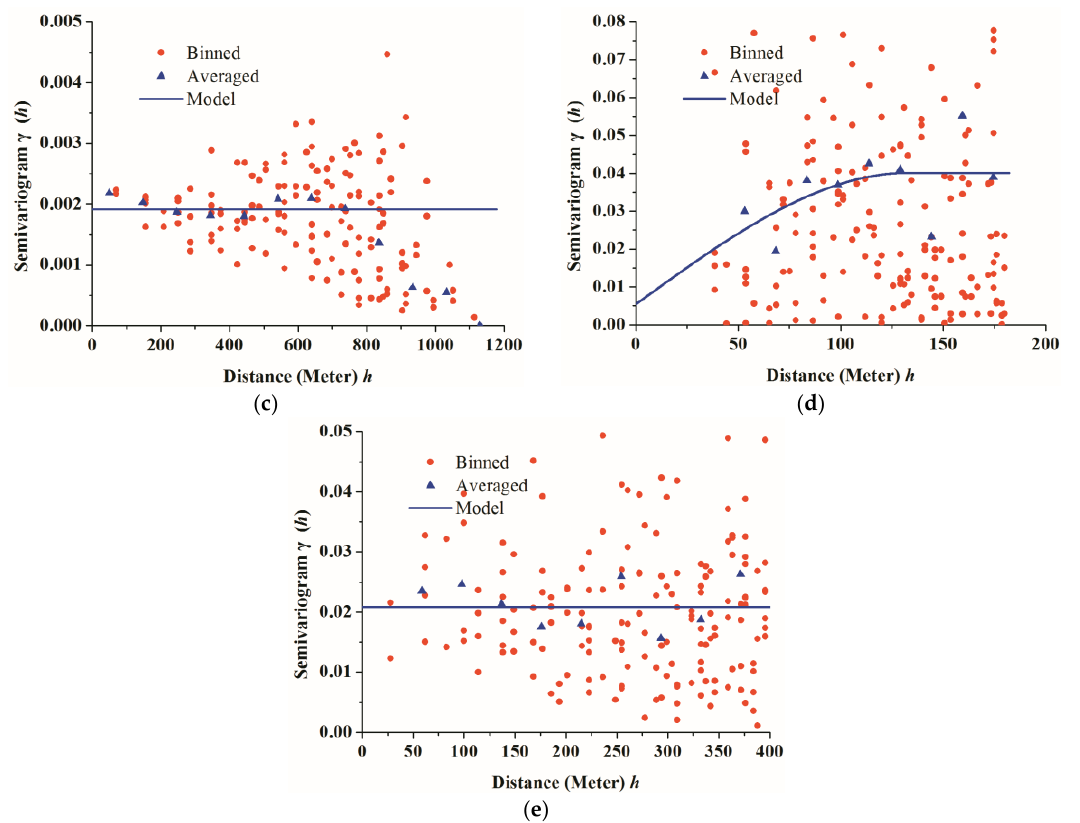
Figure 5. Semivariograms of in situ soil moisture observations: ( a ) 30 June data, using a Gaussian model; ( b ) 7 July data, using a Spherical model; ( c ) 14 July data, using a pure nugget effect model; ( d ) 26 July, using a Spherical model; and ( e ) 2 August, using a pure nugget effect model. ( a ) 0.002 · Nugget + 0.002 · Gaussian(1179.7); ( b ) 0.001 · Nugget + 0.005 · Spherical(139.0); ( c ) 0.002 · Nugget; ( d ) 0.005 · Nugget + 0.034 · Spherical(132.0); ( e ) 0.021 · Nugget. Table 1. Cross-validation of kriging on SoilNET soil moisture observations. ME (m 3 · m − 3 ): the mean error. MSE (m 3 · m − 3 ) 2 : the mean squared error. MSDR: the mean squared deviation